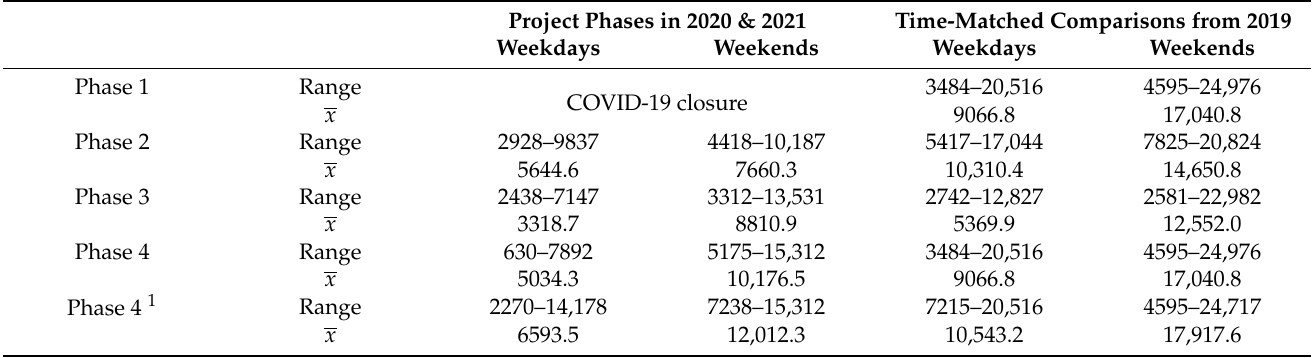
Table 2. Comparison of guest counts on weekdays and weekends on space use collection days during the study periods with time-matched periods from